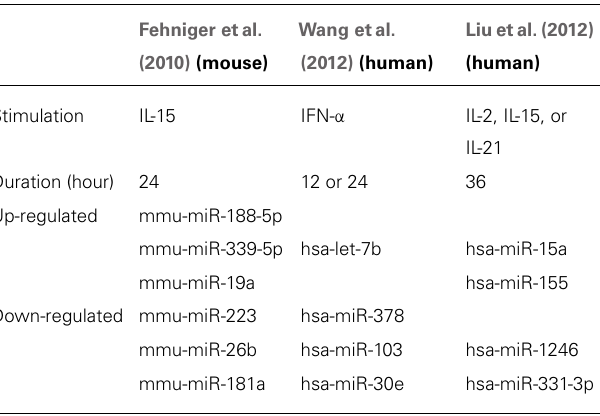
miRNAs were selected based on the following criteria: top threefold change within the top 12 expressed miRNAs (Wang etal., 2012), significant miRNAs consistently changed by the listed stimulation (Liu etal., 2012), and top threefold change (Fehniger etal.,